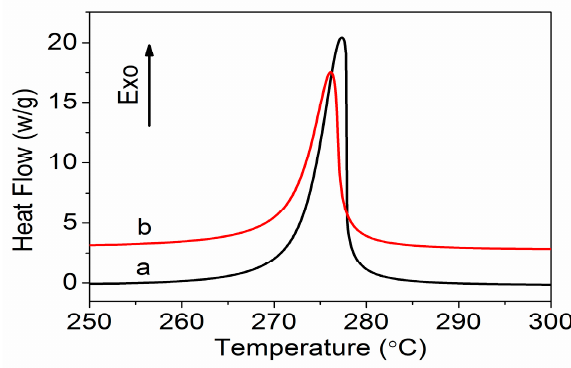
Figure 5. Differential scanning calorimetry (DSC) curves of ( a ) PAN homopolymer and ( b ) amino-CNT/PAN microspheres in a nitrogen atmosphere. PAN microspheres in a nitrogen Table 2. Differential scanning calorimetry (DSC) data for PAN homopolymer and amino-CNT/PAN microspheres in a nitrogen atmosphere.